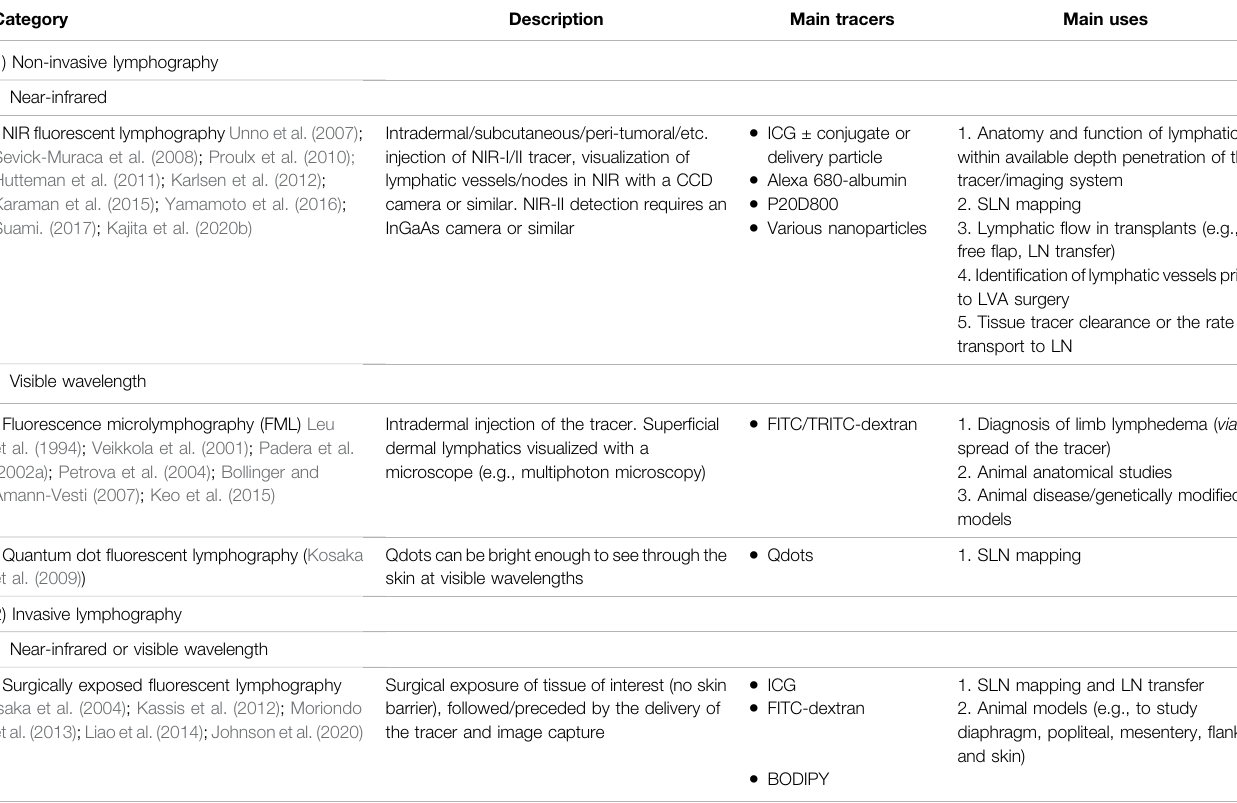
TABLE 1 | Lymphatic fl uorescent imaging can be broadly divided into non-invasive (skin intact) and invasive (surgically exposed) imaging. Non-invasive imaging normally requires a NIR tracer, unless only super fi cial skin lymphatics are viewed through a microscope (FML), or the tracer is particularly bright (Qdots). Surgically exposed lymphography can either use a NIR or visible wavelength fl uorescent